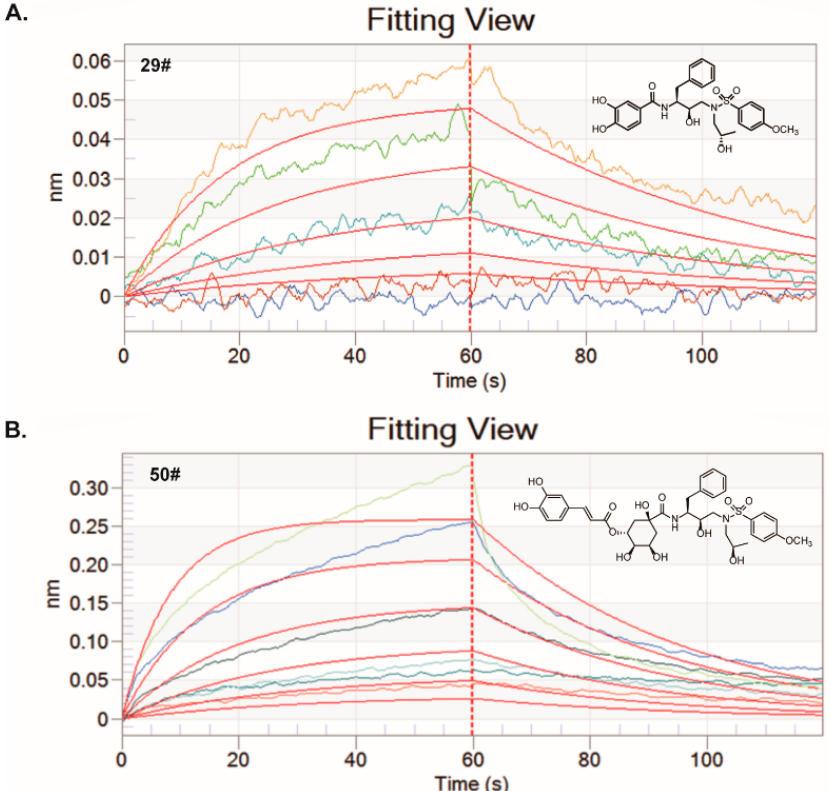
Figure 4. BLI assays for the binding of the hits to the 3CL pro protein in vitro. Both of the hits at different serially diluted concentrations were titrated into a fixed concentration of the labeled 3CL pro protein (100 nM). ( A ) The kinetic fitting curves for the interaction between 29# and 3CL pro protein was analyzed by BLI assay. Five different concentrations including 6.25, 12.5, 25, 50, and 100 μ M were set. ( B ) The kinetic fitting curves for the interaction between 50# and 3CL pro protein was analyzed by BLI assay. Six different concentrations including 6.25, 12.5, 25, 50, 100 and 200 μ M were set.